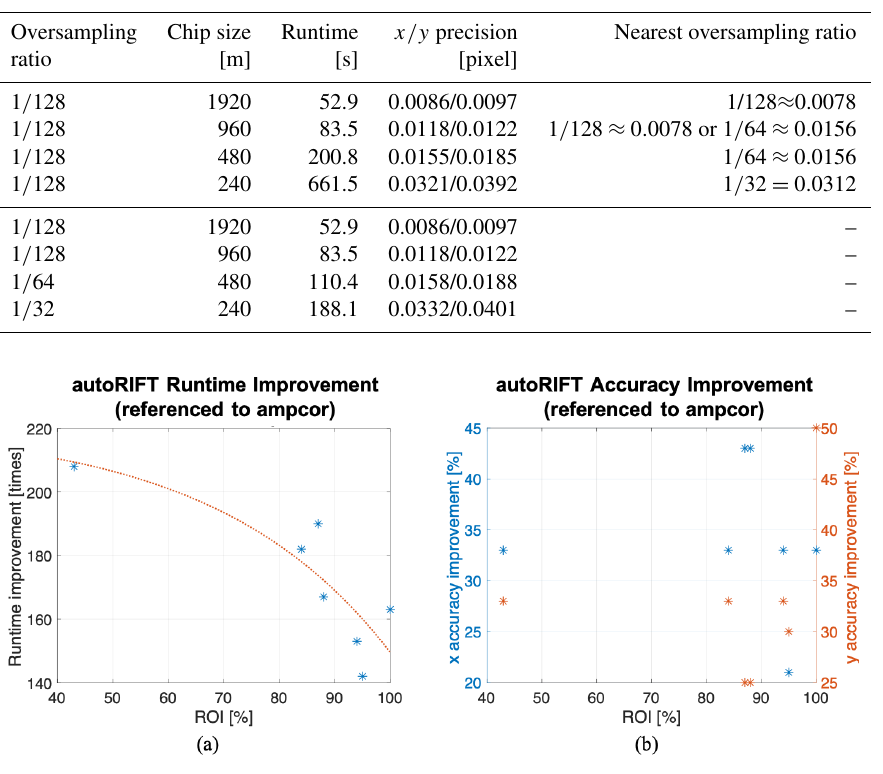
Figure 6. Apples to apples comparison between autoRIFT and ampcor: (a) runtime improvement, (b) x/y (range/azimuth) accuracy im- provement. Both autoRIFT and ampcor use the same setting for offset tracking as in Lei et al. (2021a): chip size of 64 × 64, grid spacing of 64 × 64, and search limit of 62 × 16. The 7 Sentinel-1 image pairs in Region 1 (frame 222 only) are